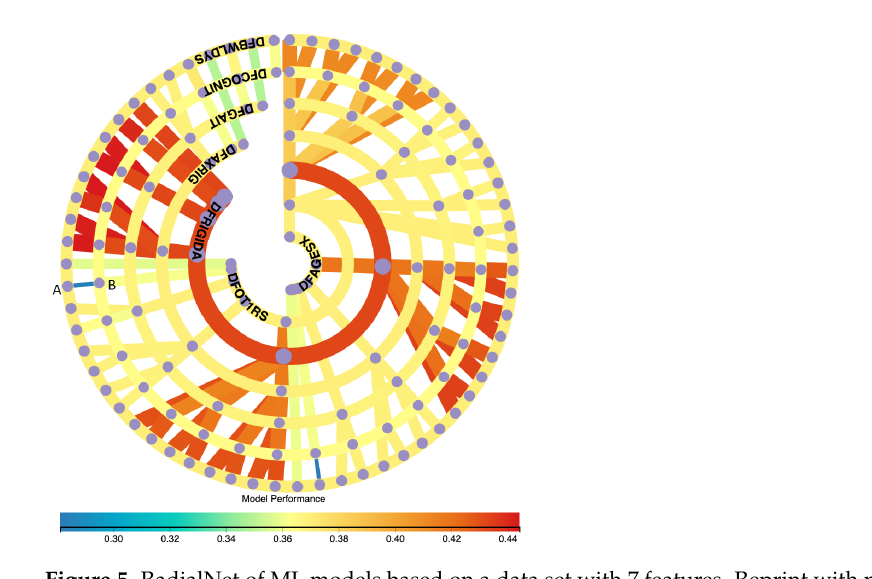
Figure 5. RadialNet of ML models based on a data set with 7 features. Reprint with permission from Jianlong Zhou, Weidong Huang and Fang Chen (2020). Copyright 2020 IEEE Pacific Visualization Symposium (PacificVis).